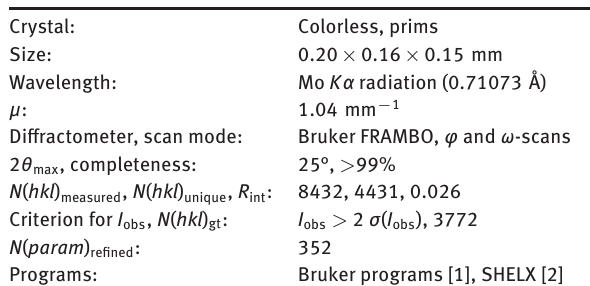
Table 1: Data collection and